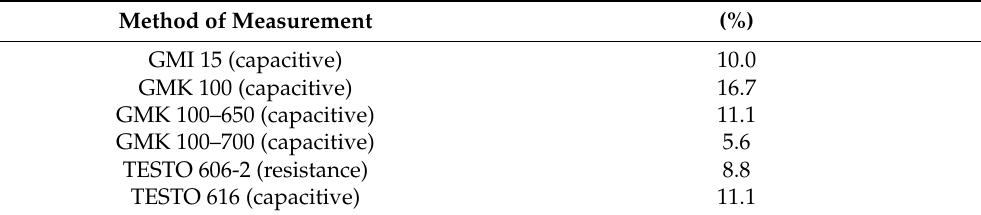
Table 1. Test results of mean values in the form of percentages for a given measurement method.